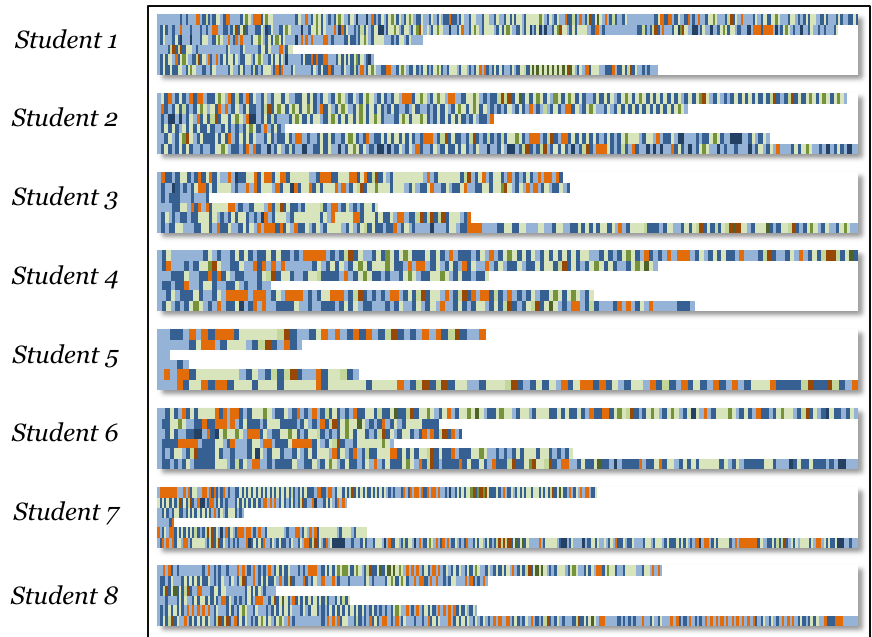
Figure 7. Behavioral interaction pattern for each individual student in Course B. Blue colors represent a student's course exploration activities, such as course viewing and other user viewing. Brown colors represent a student's interactions with the Moodle LMS, and green colors represent a student's interactions with peers. Each square in the pattern graph represents one occurrence of the case. Each pattern line represents the total behavioral interactions that occurred in each week. Through visual representations of behavioral interactions, different patterns were identified in the two courses. Most of the students in course A showed a ( ) shape of behavioral patterns, while students in Course B showed a ( ) shape of behavioral patterns. In other words, students in Course A tend to show more behavior interactions as they move toward the end of the semester, while students in course B showed higher behavioral interactions in the first week of the semester and also at the end of the